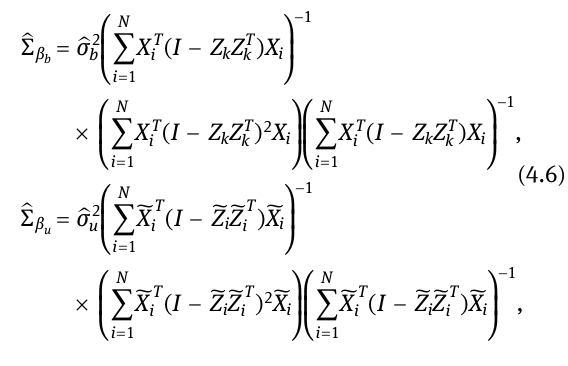
Table 2: Estimates by various groups Period Intercept Balanced